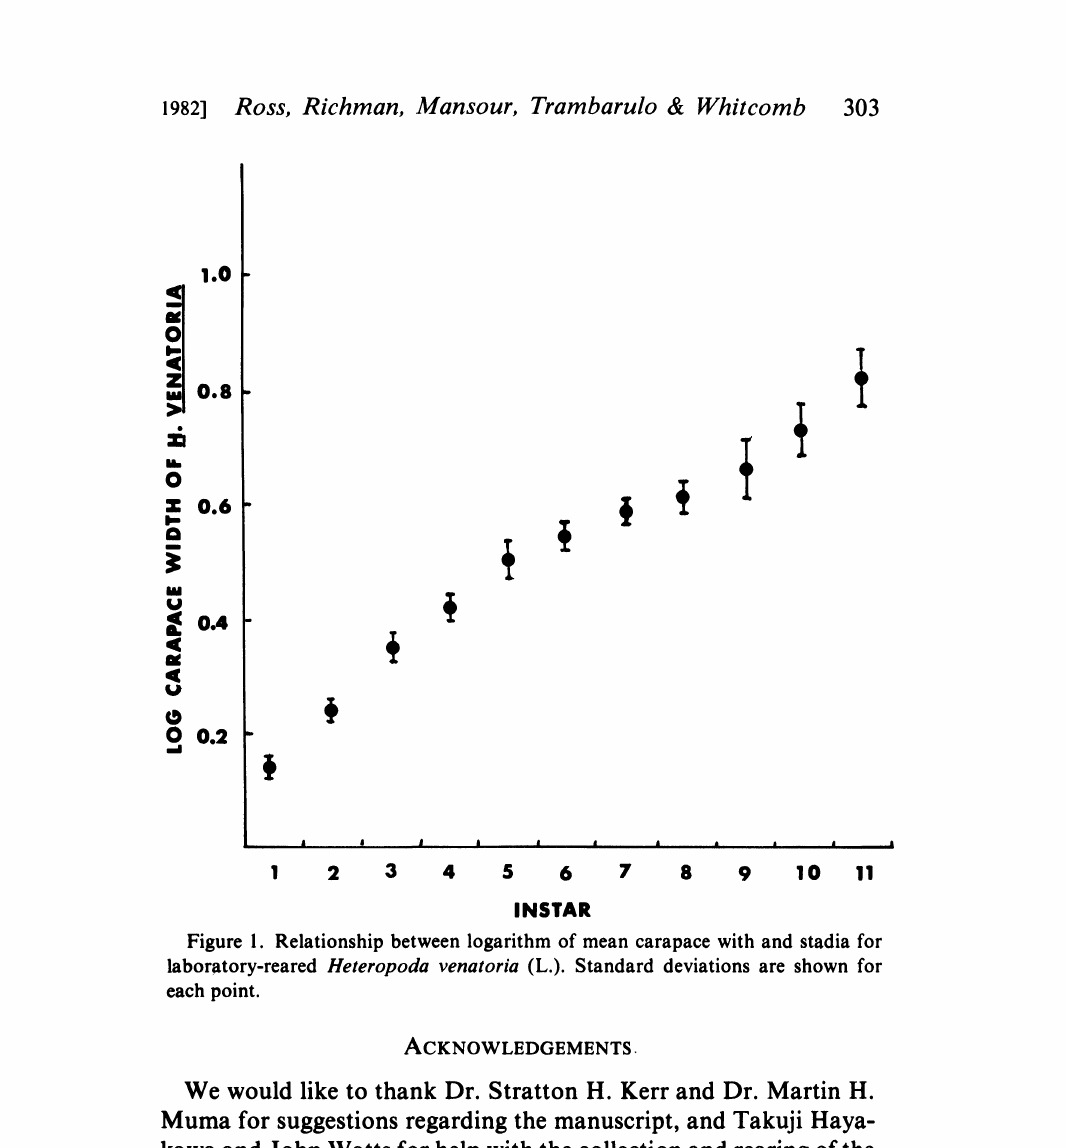
Figure 1. Relationship between logarithm of mean carapace with and stadia for laboratory-reared Heteropoda venatoria (L.). Standard deviations are shown for each